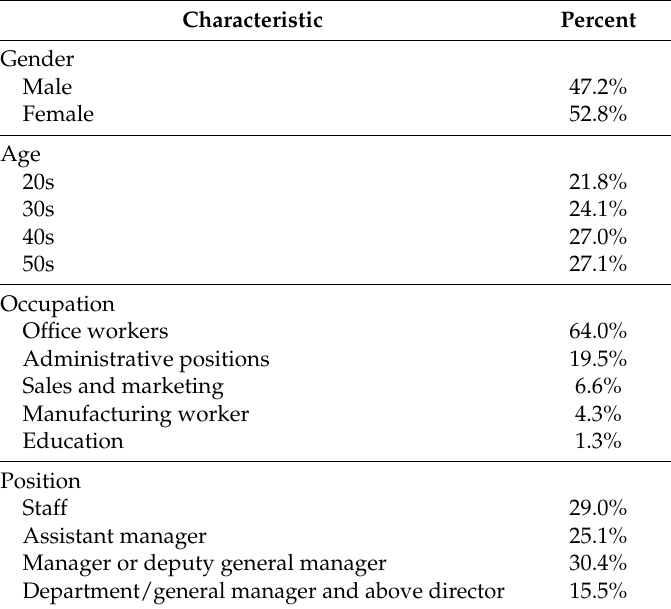
Table 1. Descriptive features of the